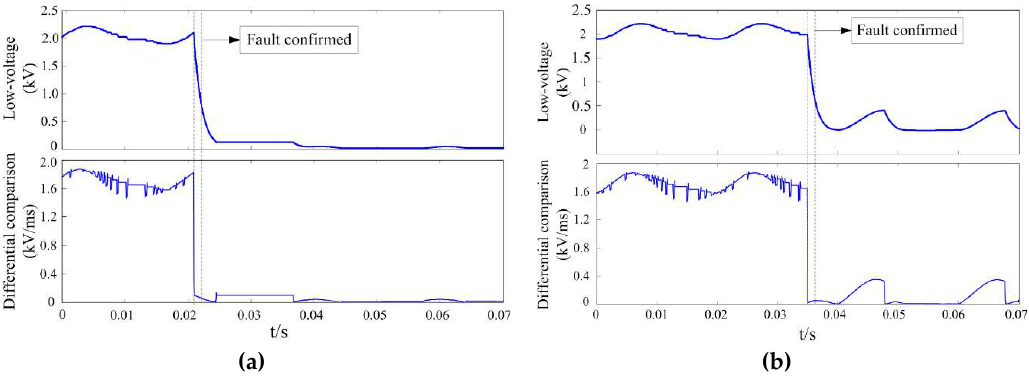
Figure 9. Performance of the proposed DCLVDM under faulty condition: ( a ) Case 1; ( b ) Case